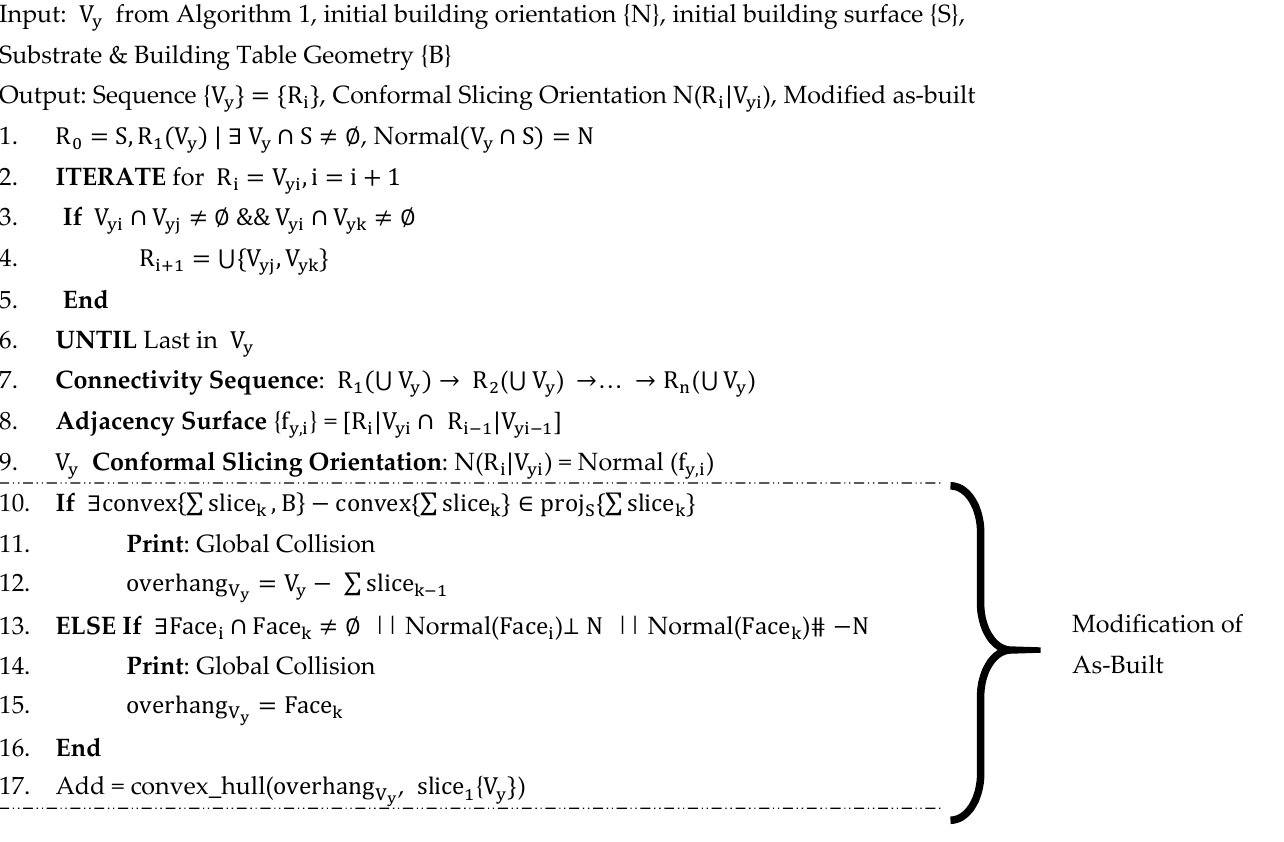
Algorithm 2: Sequencing Single-Body Features (V y ) and Modify As-built Model (M). Sequencing and modification of as-built model.